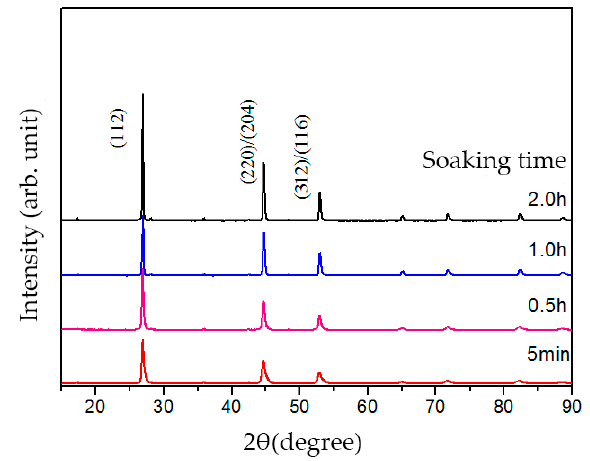
Figure 5. The crystallinity variation of sintered compact with time under 30 MPa pressure at 580 °C.